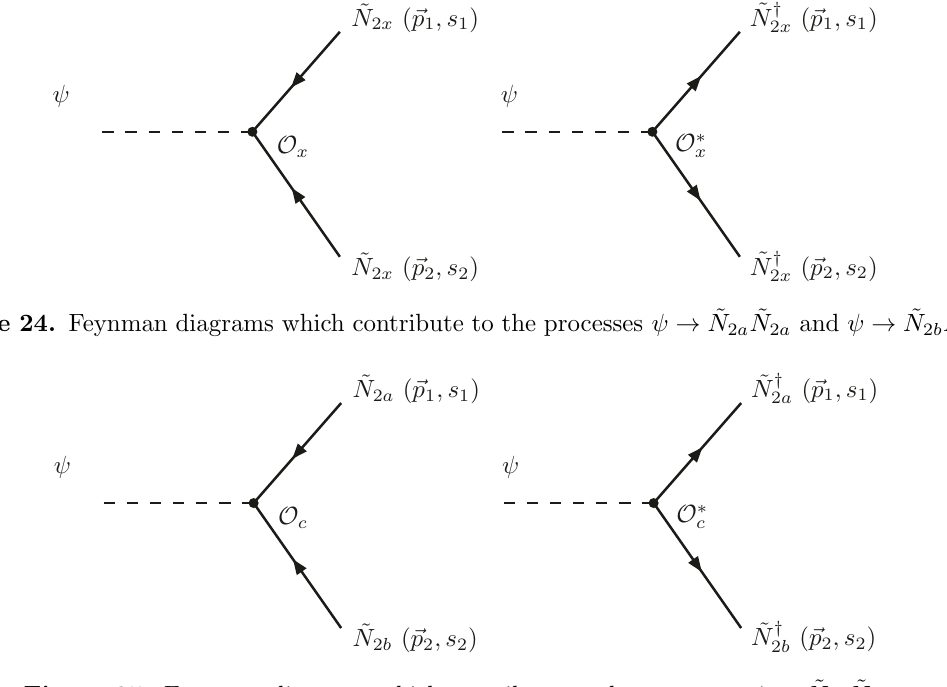
Figure 25. Feynman diagrams which contribute to the processes ! ~ N 2 a ~ N 2 b